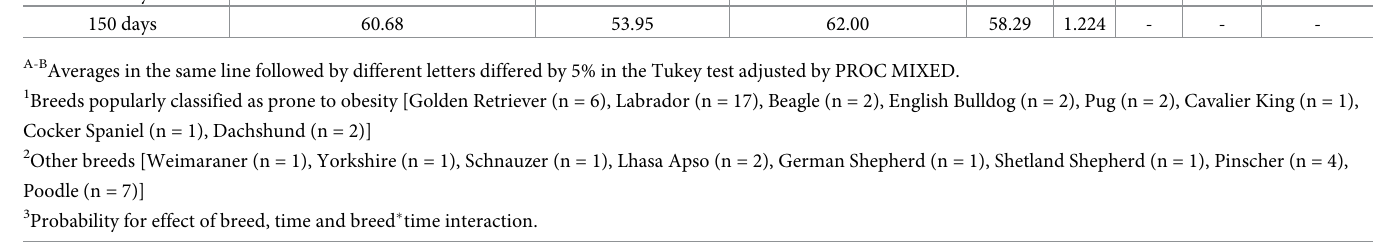
Adjustment of the weight loss equation based on the weight loss period Regarding the development of a weight loss mathematical equation adjusted for the weight loss period, a general equation for an accurate energy requirement prediction (p < 0.001) was proposed (Fig 1). The regression analyses and complete distribution of the kcal x TW 0.75 according to reproductive status (Fig 2), age (Fig 3), body size (Fig 4), and breed (Fig 5) were also significant (p < 0.001).